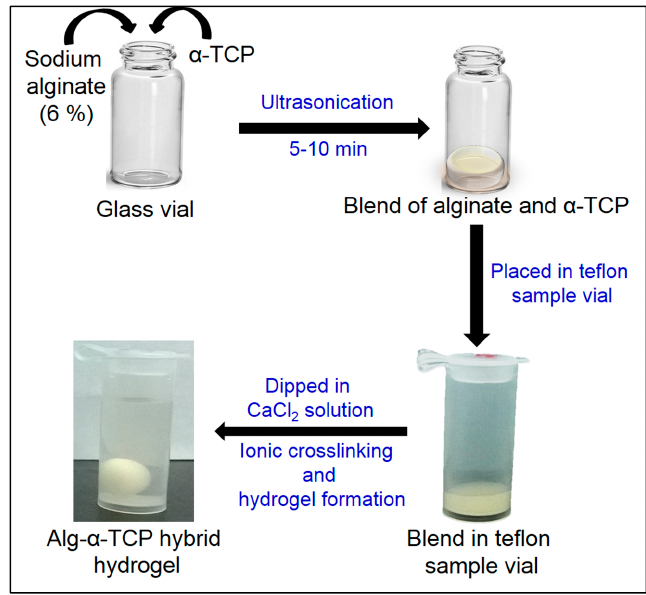
Figure 1. Schematic presentation of the fabrication process of Alg- α -TCP hybrid gel.